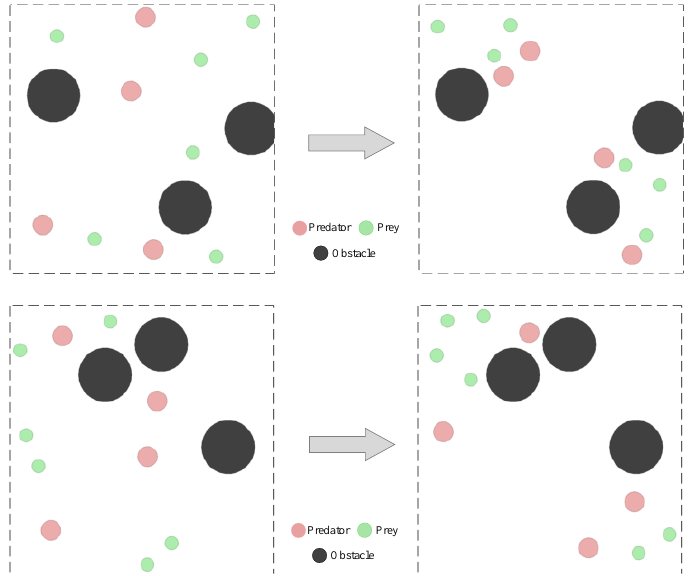
Figure 14. Training effect diagram of CMCL algorithm in competitive environment.